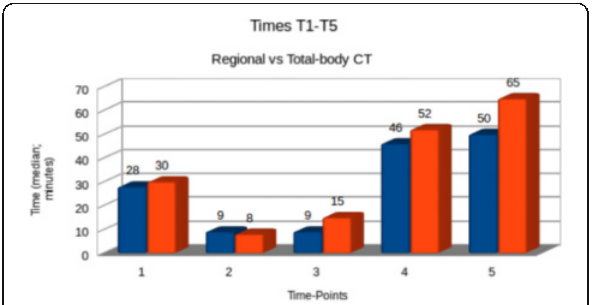
Fig. 115 (abstract A300). Times vs CT